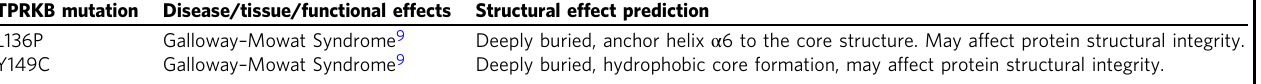
Table 2 Disease mutations of human